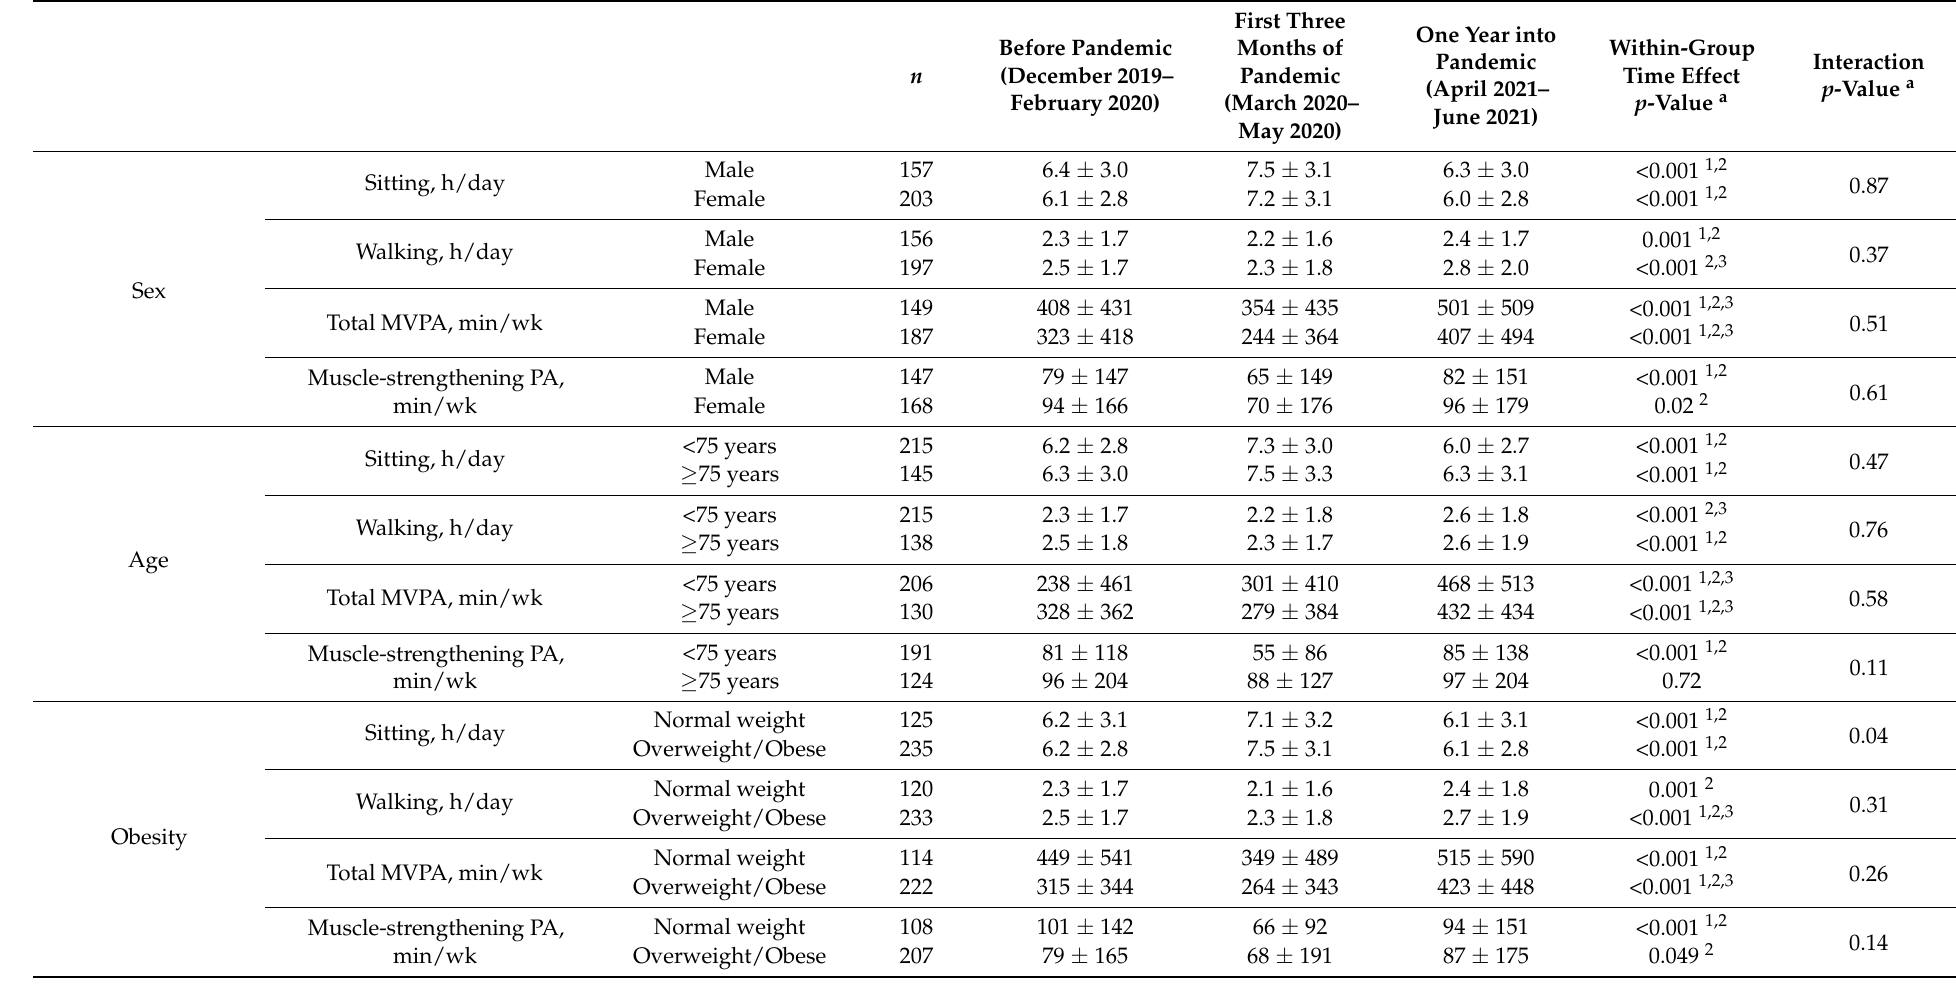
Table 2. Changes in physical activity and sitting time during the COVID-19 pandemic stratified by sex, age, obesity, co-morbidities, and meeting physical-activity guidelines before the